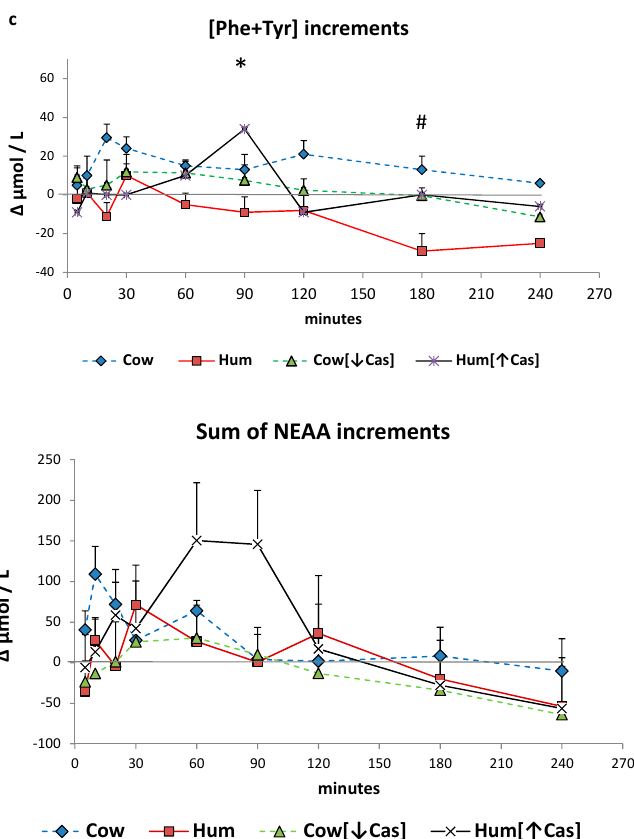
Figure 5. Plasma amino acid increments. Abbreviations: AA: amino acids; BCAA: branched-chain AA; Phe: phenylalanine; Tyr: tyrosine; Hum: human; Cow [ ↓ Cas]: low-casein cow milk; Hum [ ↑ Cas]: high-casein human milk. Legend to Figure 5: (Top panel, ( a )): Increments vs. baseline of the sum of total amino acid [AA] concentration over the 4-h study period following milk ingestion. The symbol (*) at 5 ′ indicates a significant difference (by the two-way ANOVA and the Fisher’s LSD test) between Cow milk [ n = 7] and either Hum [ n = 7] [ p < 0.02], Cow[ ↓ Cas] [ n = 10] ( p < 0.025) or Hum[ ↑ Cas] [ n = 7] ( p < 0.04) milk. The symbol (#) at 10 ′ indicates a significant different between